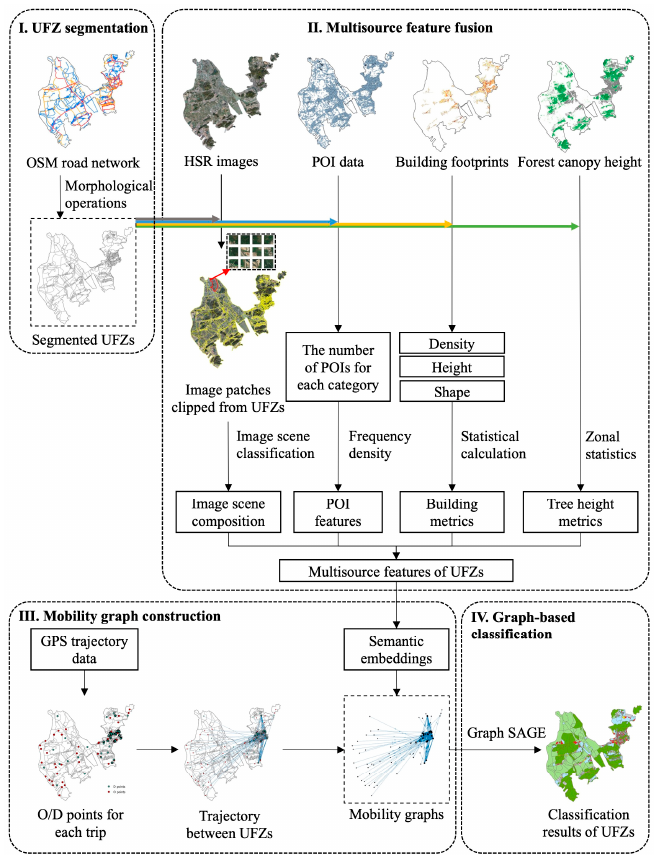
Figure 4. The proposed UFZ classification